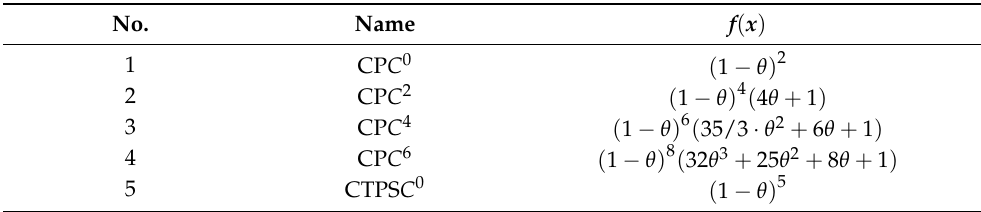
Table 1. Radial basis functions (RBFs) with compact functions ( θ = x and r is the support radius).